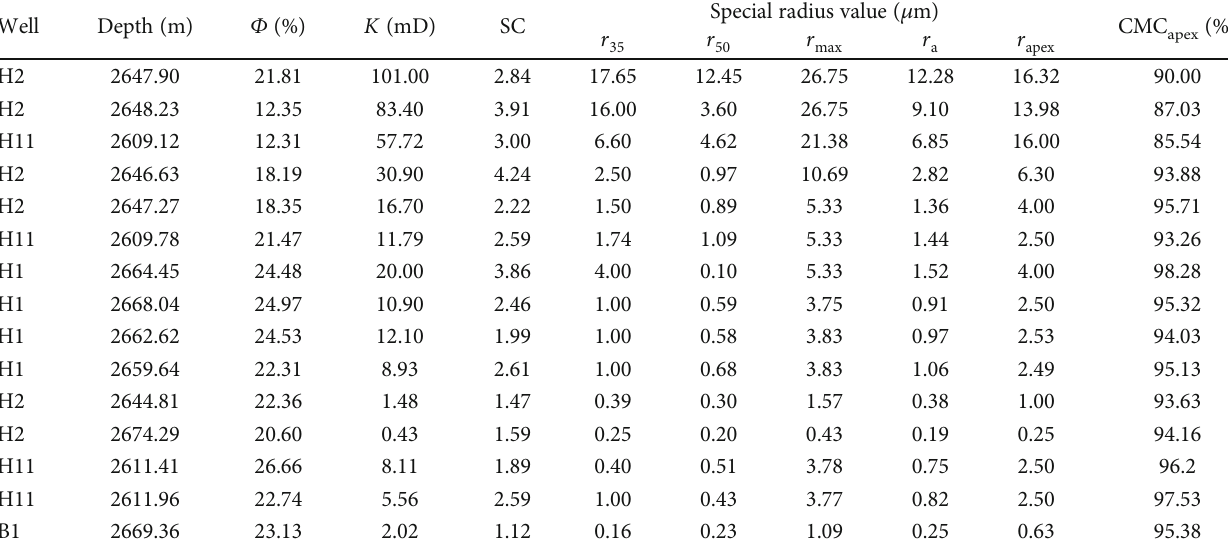
Table 1: HPMI data of the K formation sample.